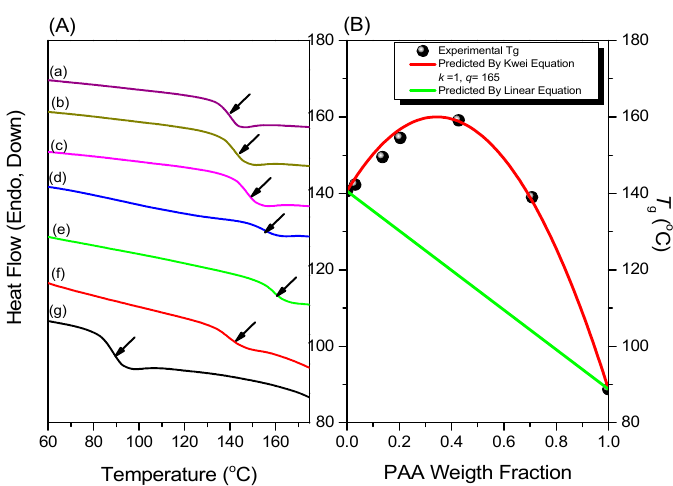
Figure 3. ( A ) DSC thermograms of PNIPAAm- co -PAA random copolymers: (a) pure PNIPAAm; (b) PNIPAAm97- co -PAA3; (c) PNIPAAm87- co -PAA13; (d) PNIPAAm80- co -PAA20; (e) PNIPAAm57- co -PAA43; (f) PNIPAAm30- co -PAA70; and (g) pure PAA. ( B ) Experimental values of T g , with lines predicted by the Kwei and linear equations. (b) Self-Association of PNIPAAm (c) Inter-Association of PNIPAAm-PAA